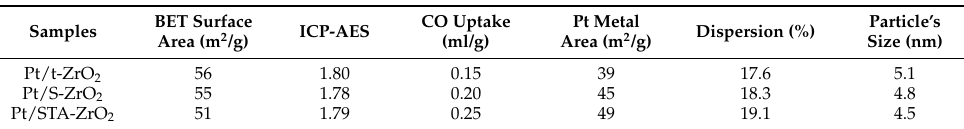
Table 1. Results of CO uptake, dispersion, metal area, and average particle size of various zirconia- based Pt catalysts.